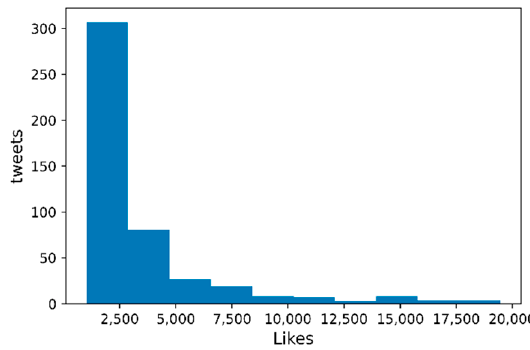
Figure 3. Buzz tweet like